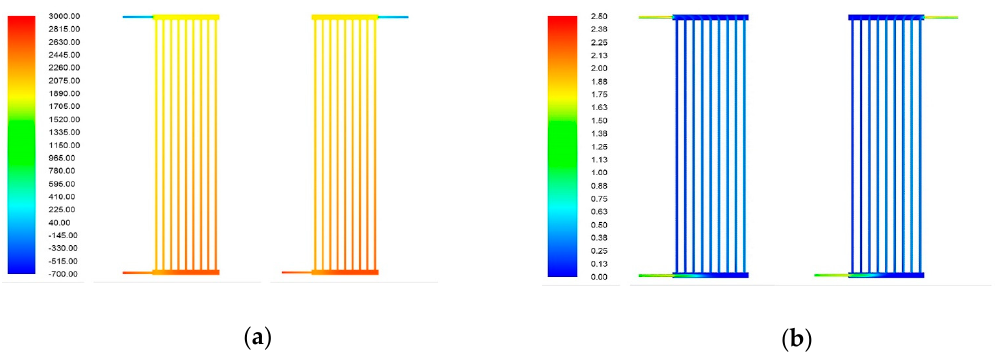
Figure 5. Flow characteristics of the base model (U- and Z-types): ( a ) Static pressure distribution; ( b ) velocity distribution.